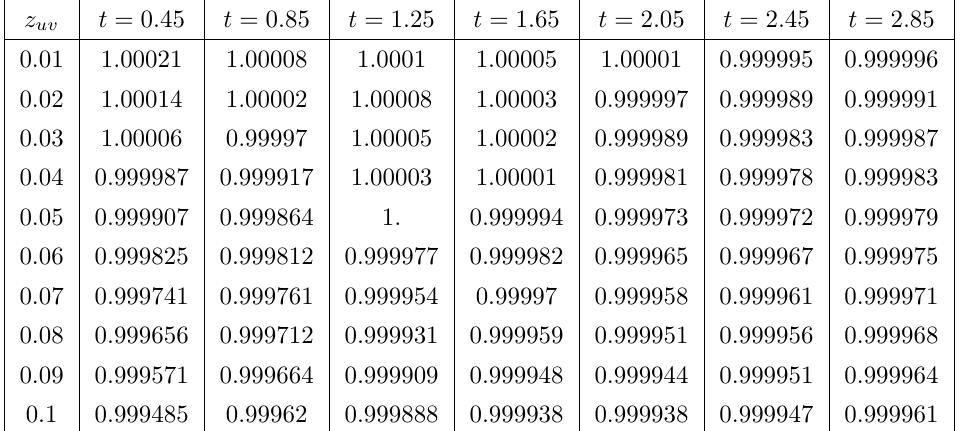
(cid:15) L Left: 3